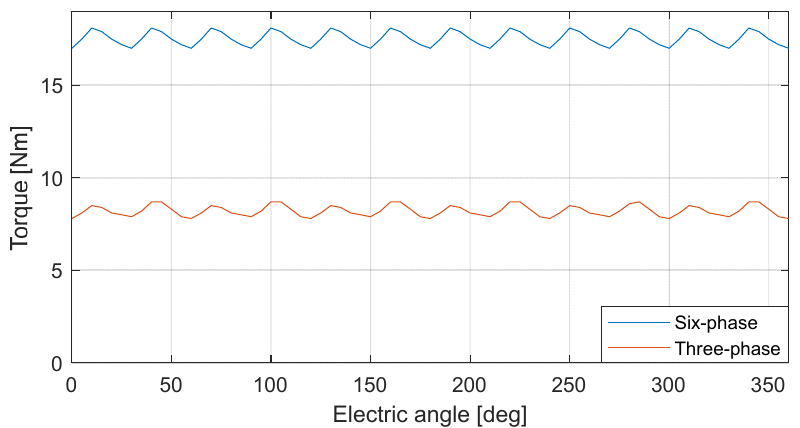
Figure 9. Torque curves of six and three phases from FEM analysis at 480 r/min and 10 A. Table 6. Torque characteristic according to currents in FEM at 480